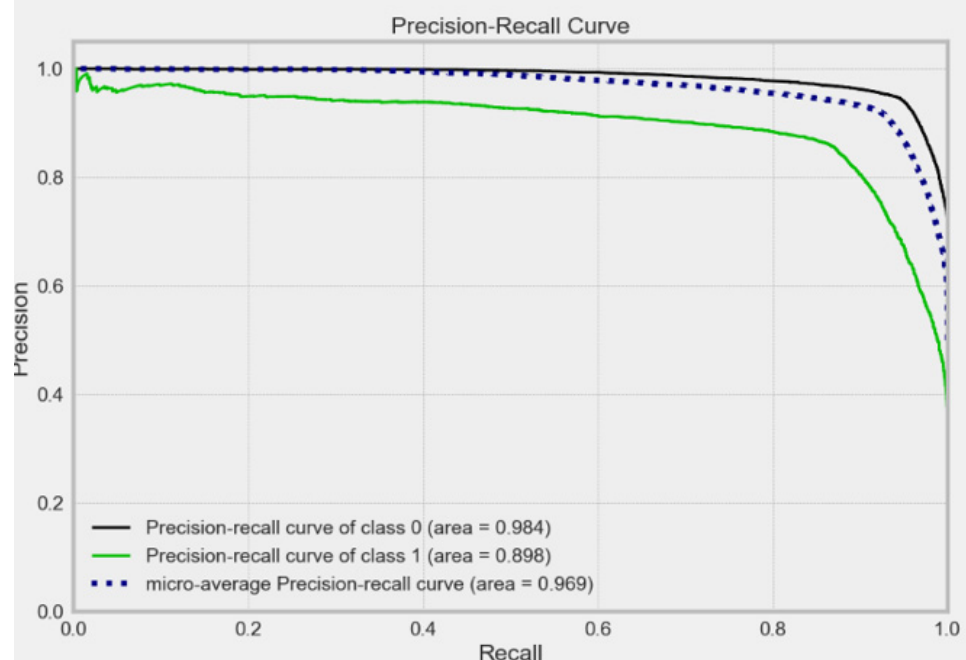
Figure 20. Precision–recall Curve for random forest model.